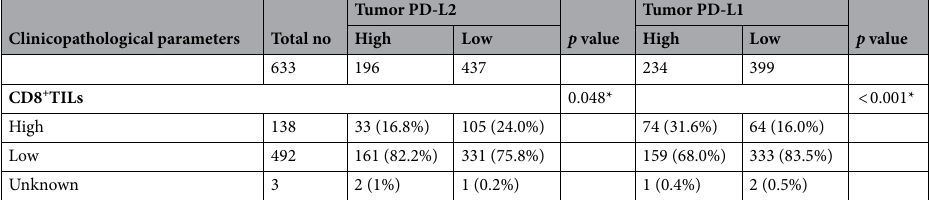
Table 4. Tumor characteristics and immune status in late-stage colon carcinoma patient (n = 633). NA: not available. The Fisher’s exact test did not include the “NA” and "unknown" group. *indicated p <0.05.